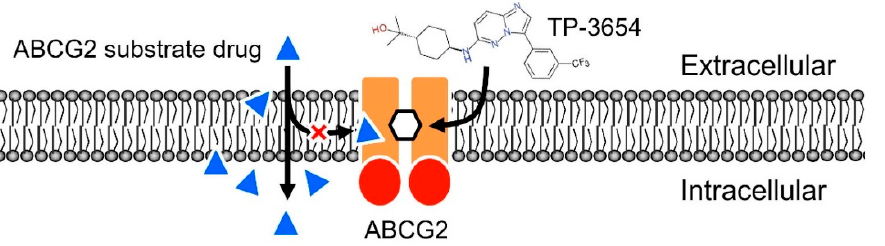
Figure 6. Schematic diagram showing TP-3654 resensitizing ABCG2-overexpressing multidrug- resistant cancer cells to cytotoxic anticancer drugs. By outcompeting the binding of ABCG2 substrate drugs (blue triangles), TP-3654 inhibits the drug efflux function of ABCG2 and increases the efficacy of ABCG2 substrate drugs in ABCG2-overexpressing cancer cells.